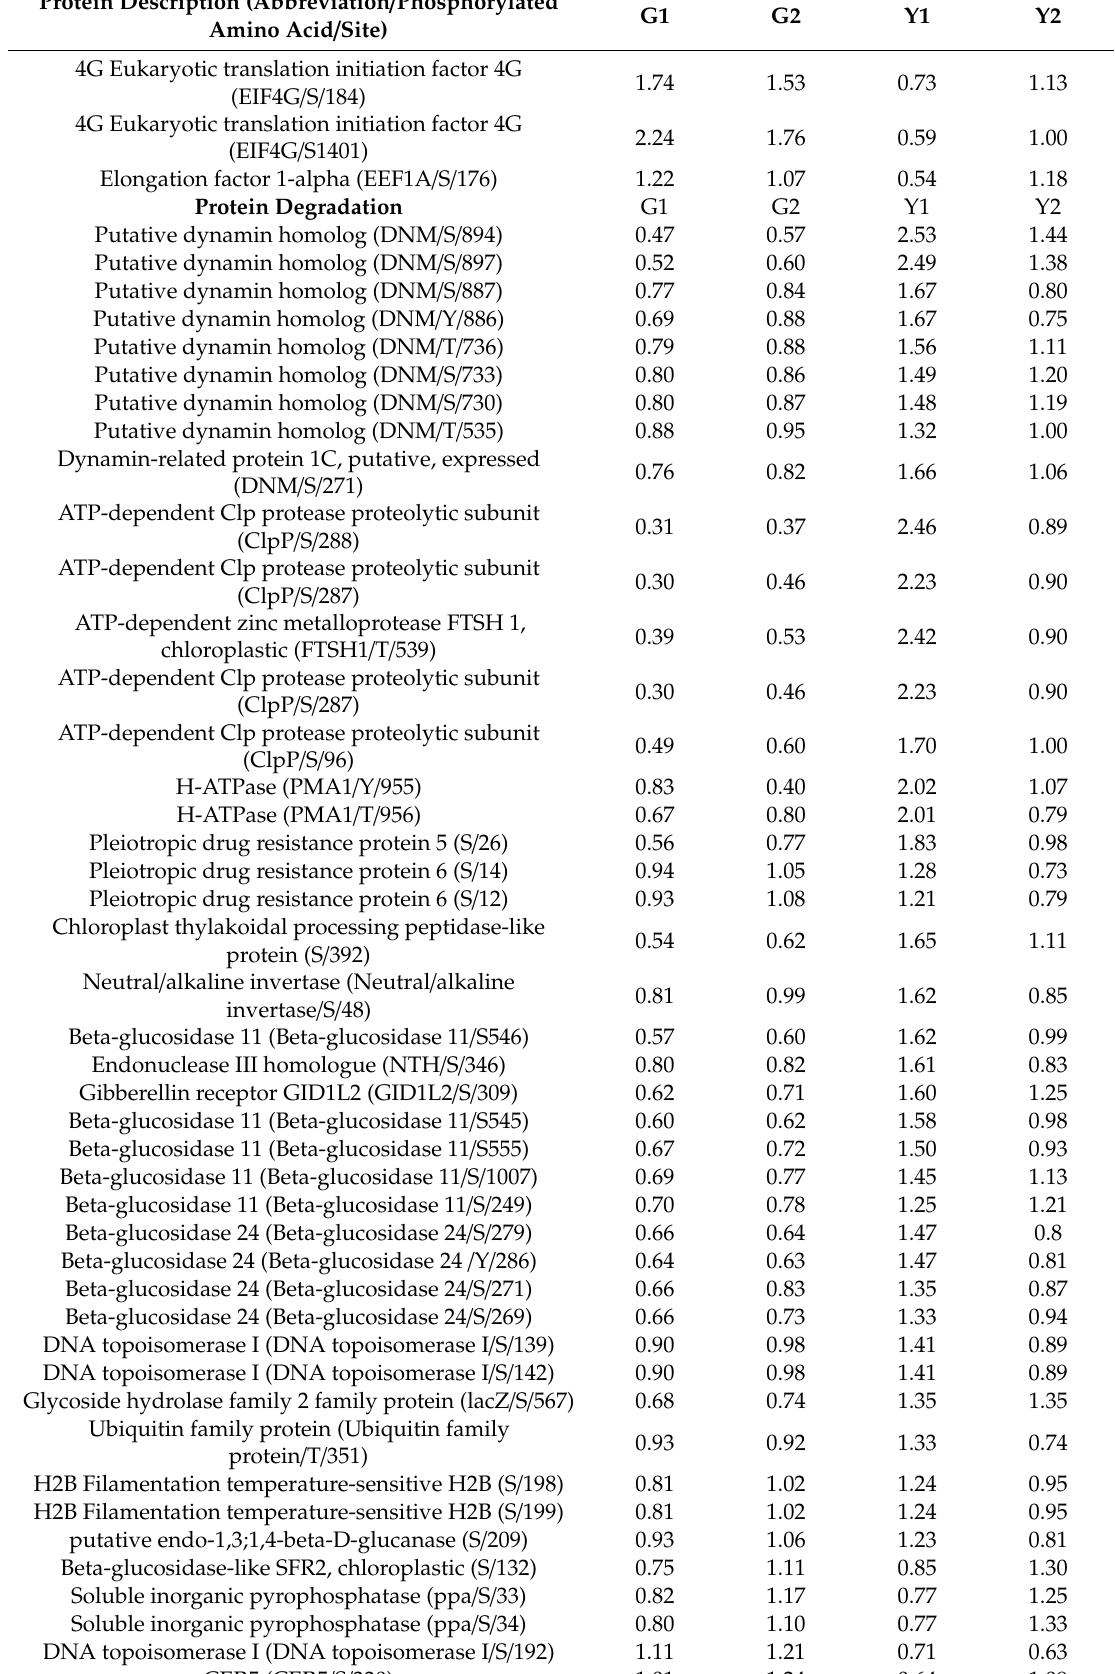
DNA topoisomerase I (DNA topoisomerase I / S /